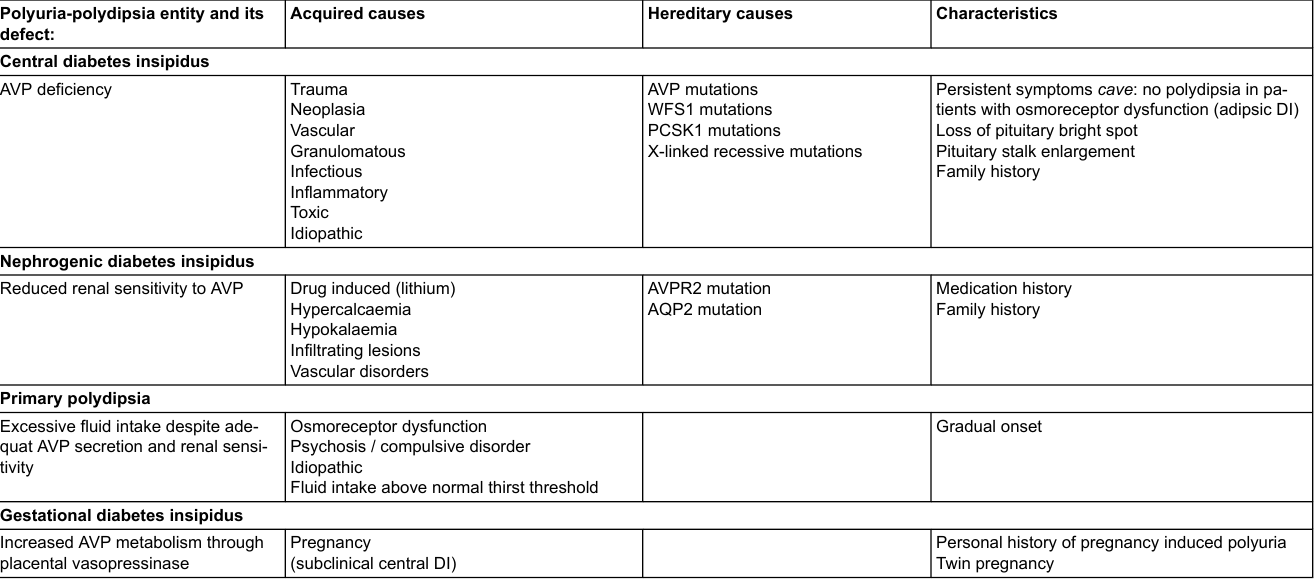
Table 1: Characteristics of the different entities of the polyuria-polydipsia syndrome. Polyuria-polydipsia entity and its defect: